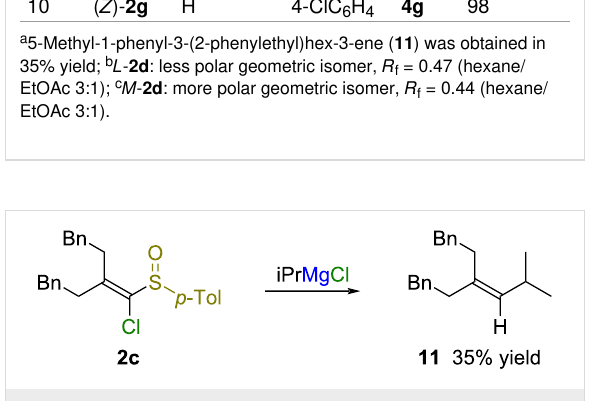
Scheme 5: Reaction of sulfoxide 2c with isopropylmagnesium chlo-